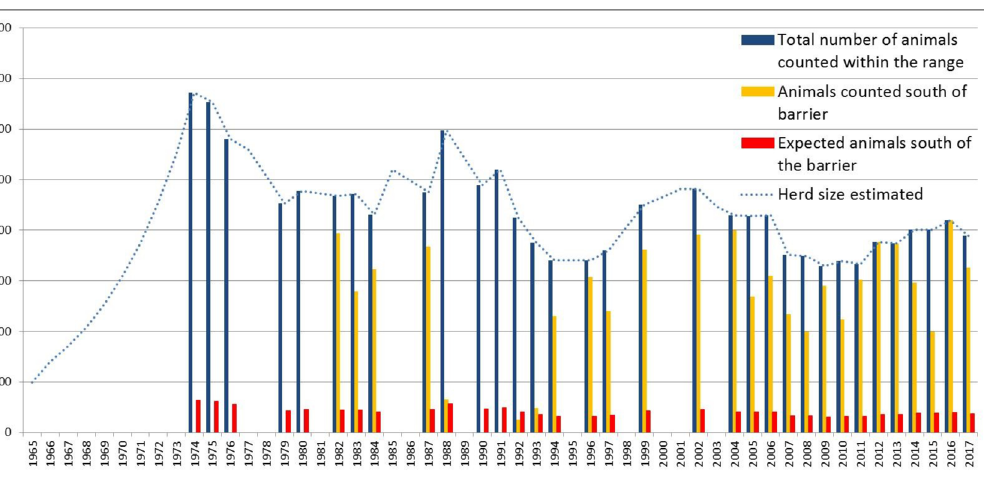
Figure 2. Wild reindeer winter herd size counted or estimated (dotted line) and the number of reindeer recorded and expected on the peninsula (bars) during air reconnaissance and animal surveys in the period 1974-2017 in North Ottadalen. Between 1965 and 1974 the yearly average growth rate was calculated as 1.24. No animals were recorded on the peninsula on the survey day in 1974-76, 1979-80 and 1990-91. The other years with no animals recorded are years when conditions prohibited air reconnaissance. The first year reindeer were found grazing on the peninsula was in 1982.